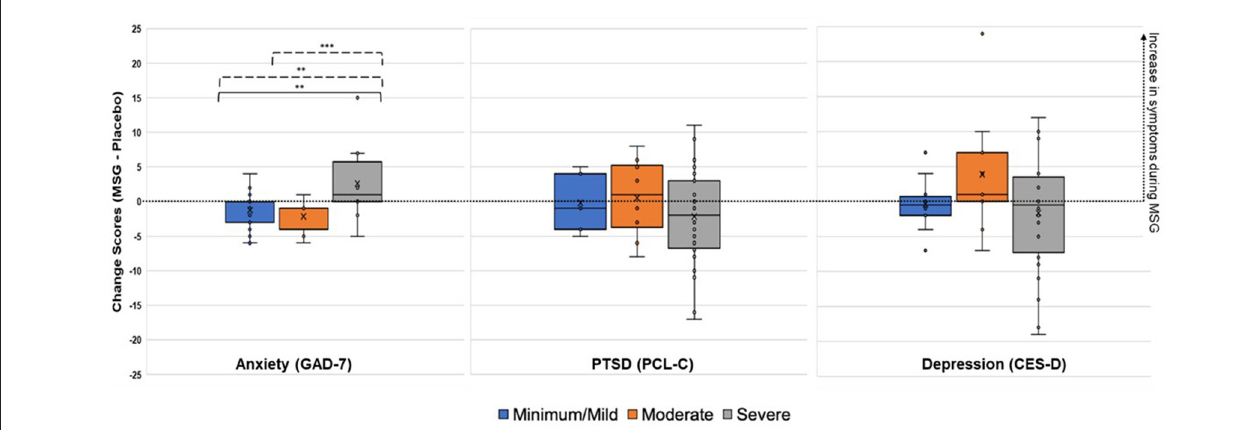
FIGURE 4 | Change Scores during Challenge (MSG minus Placebo) for Anxiety, PTSD, and Depression Symptoms. Positive change score indicates increased reporting of symptoms during MSG challenge, while negative change scores indicate increased reporting of symptoms during placebo. Minimal/mild, Moderate, and Severe categories were determined by baseline symptom severity. * p < 0.05, ** p < 0.01, *** p < 0.001 (uncorrected). Solid line, LS mean difference during placebo. Dotted line, LS mean difference during